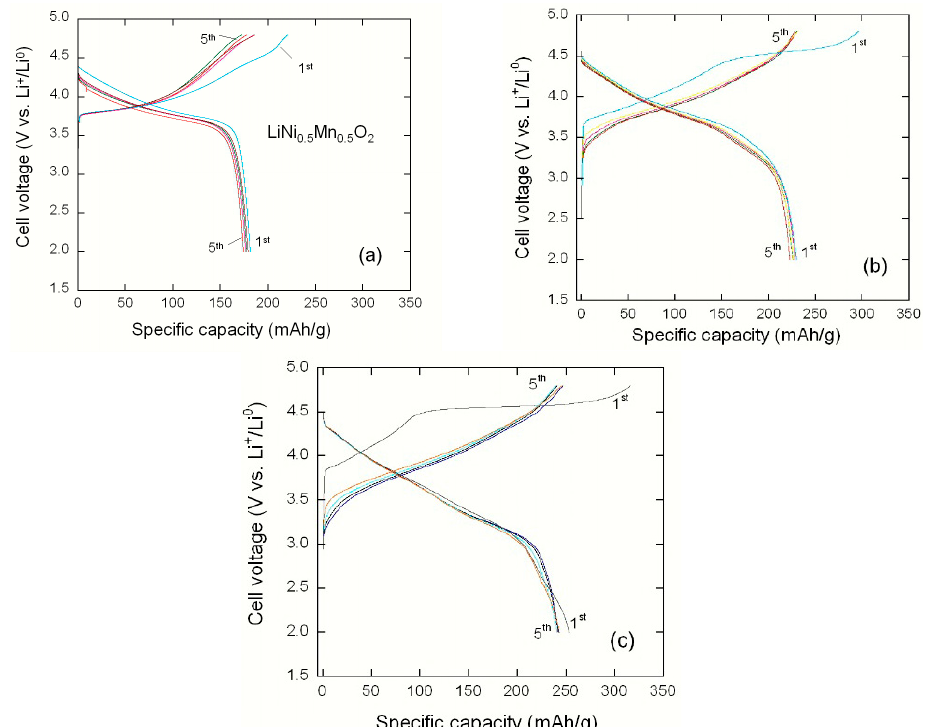
Figure 21. Charge–discharge profiles of Li//Li(Ni x Li (1/3-2x/3) Mn (2/3-x/3) )O 2 coin cells: ( a ) LiNi 0.5 Mn 0.5 O 2 ; ( b ) Li 1.134 Ni 0.3 Mn 0.556 O 2 ; and ( c ) Li 1.2 Ni 0.2 Mn 0.6 O 2 . Cycles were carried out at C/10 rate (30 mA·g − 1 ) in the potential range 2.0–4.8 V vs. Li 0 /Li + .